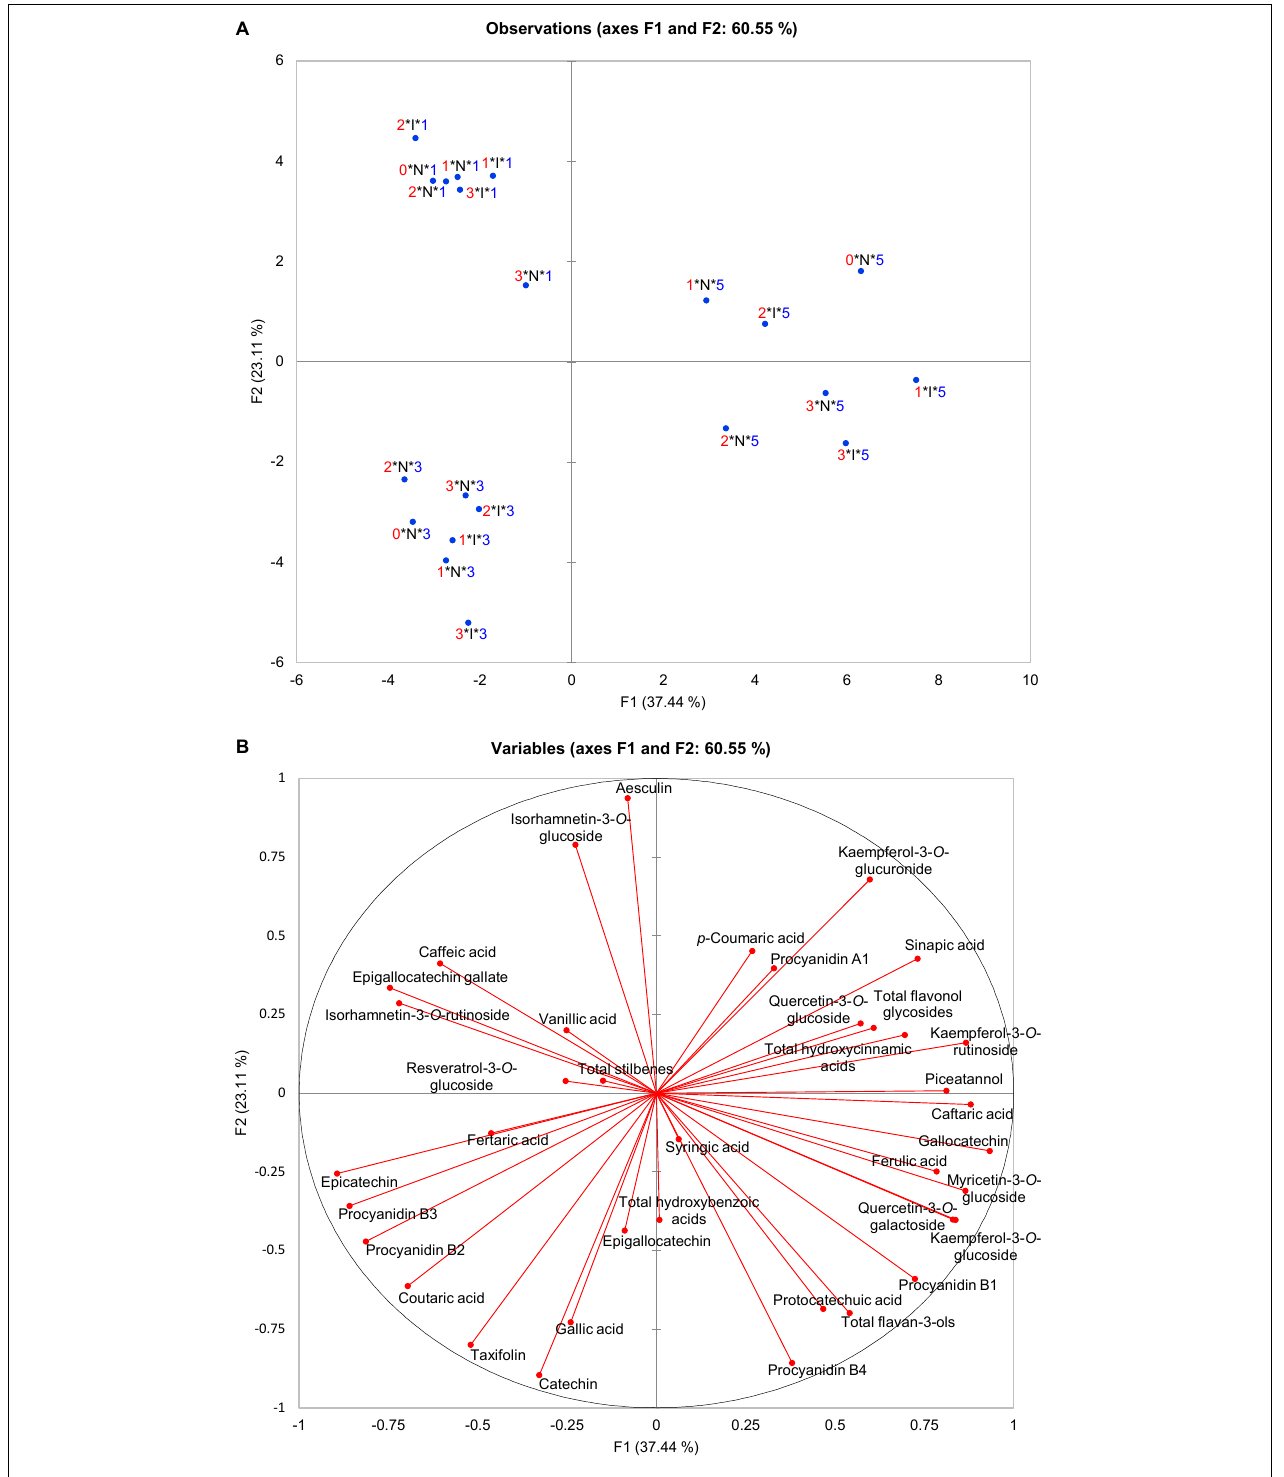
FIGURE 1 | Principal component analysis (PCA) scatter plot depicting (A) three OIV classes of susceptibility (1, 3, and 5— V. vinifera varieties) based on the polyphenolic composition of their leaves before and after artificial P. viticola inoculation at 0, 24, 48, and 96 hpi in the space defined by the first two principal components explaining 60.55% of the variability; (B) the vector diagram of correlation among the content of polyphenolic compounds and the first two principal components. 0, 1, 2, 3, Terms of sampling (0, 24, 48, and 96 hpi); N, I, Non-inoculated and inoculated observations; 1, 3, 5, OIV classes of resistance.